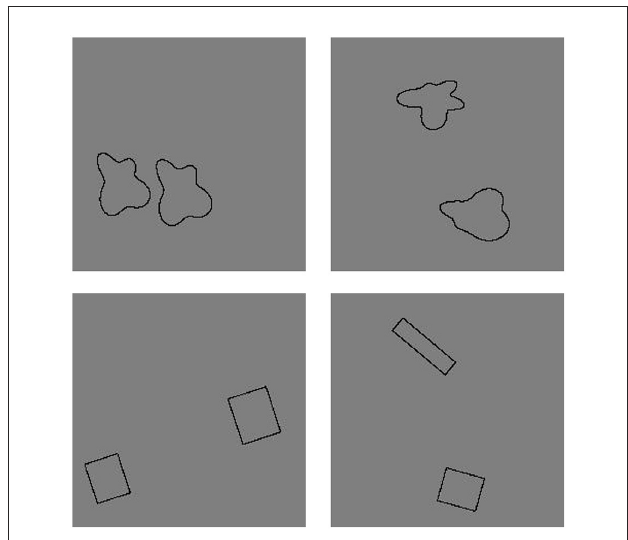
FIGURE2 Example generalization test images in Experiment 1b. (Top) A “Same” and a “Different” image for the first generalization test. (Bottom) A “Same” and a “Different” image from the second generalization test.